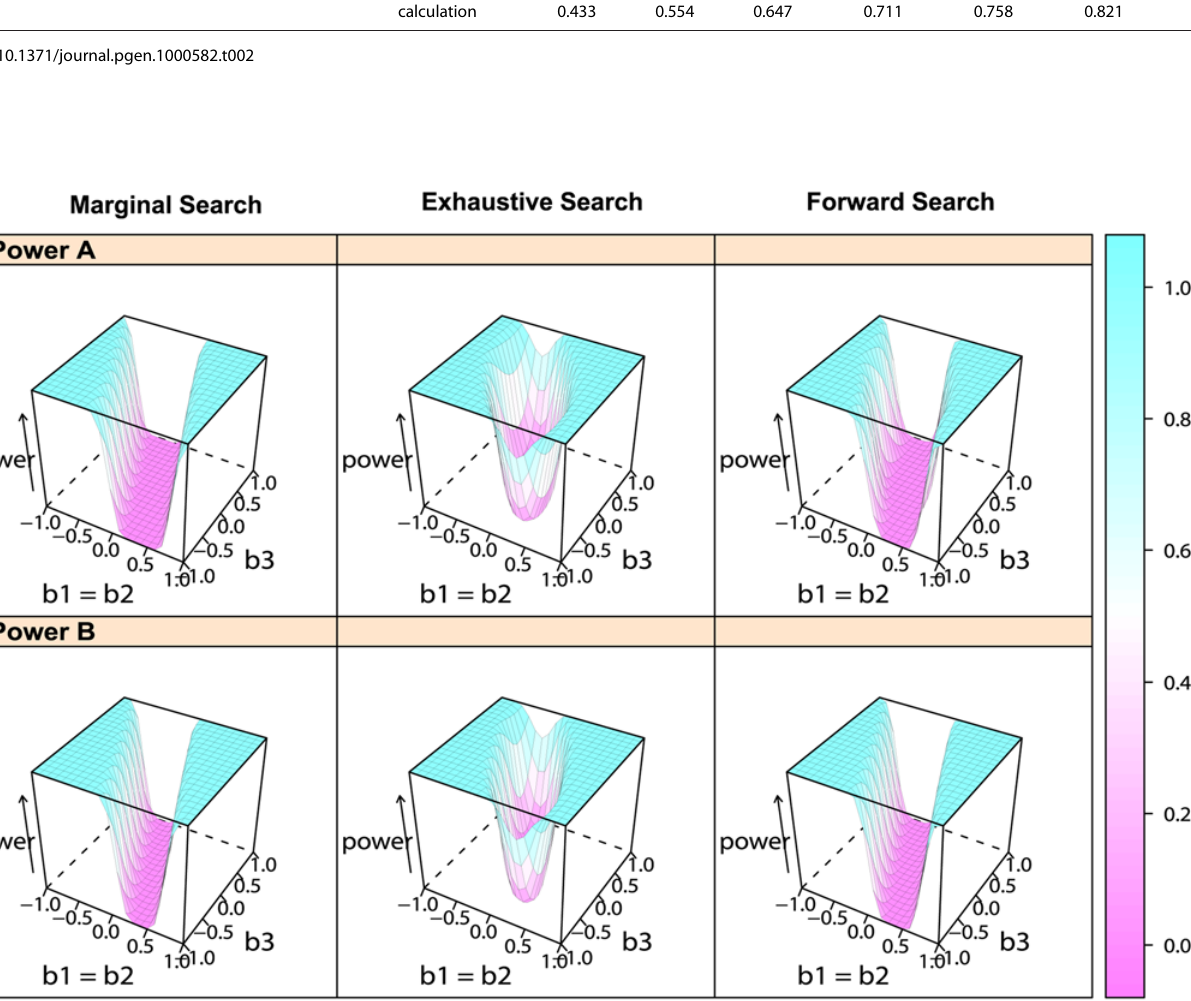
Figure 1. 3D plots of statistical power over genetic model space. The results of power for the three model selection methods: marginal search in the left column, exhaustive search in the middle column and forward search in the right column. Two definitions of power (A) for detecting the true model or both true SNPs in marginal search in row 1, and (B) for detecting either true SNP in row 2 are considered. We consider genetic models with the main effects b 1 = b 2 varying from 2 1 to 1 and the epistatic effect b 3 varying from 2 1 to 1. The allele frequency q j =0.3, j =1, …, p , and the false discovery number R is set to be 10.